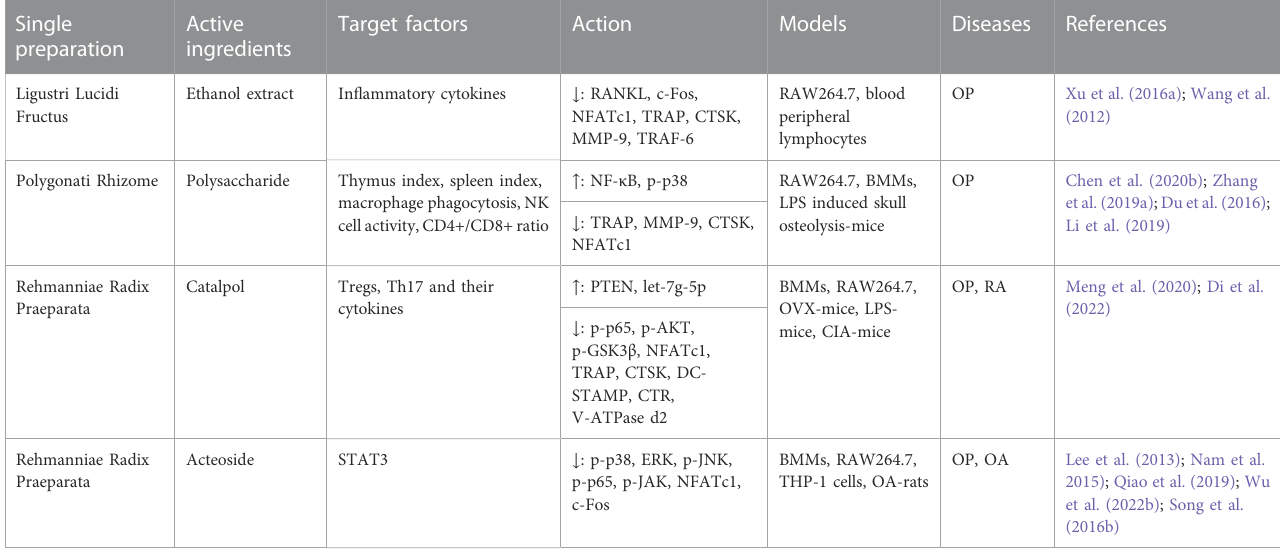
TABLE 4 Immunoregulation mechanisms by which nourishing kidney-yin of single preparations and their active ingredients inhibit osteoclastogenesis. Single